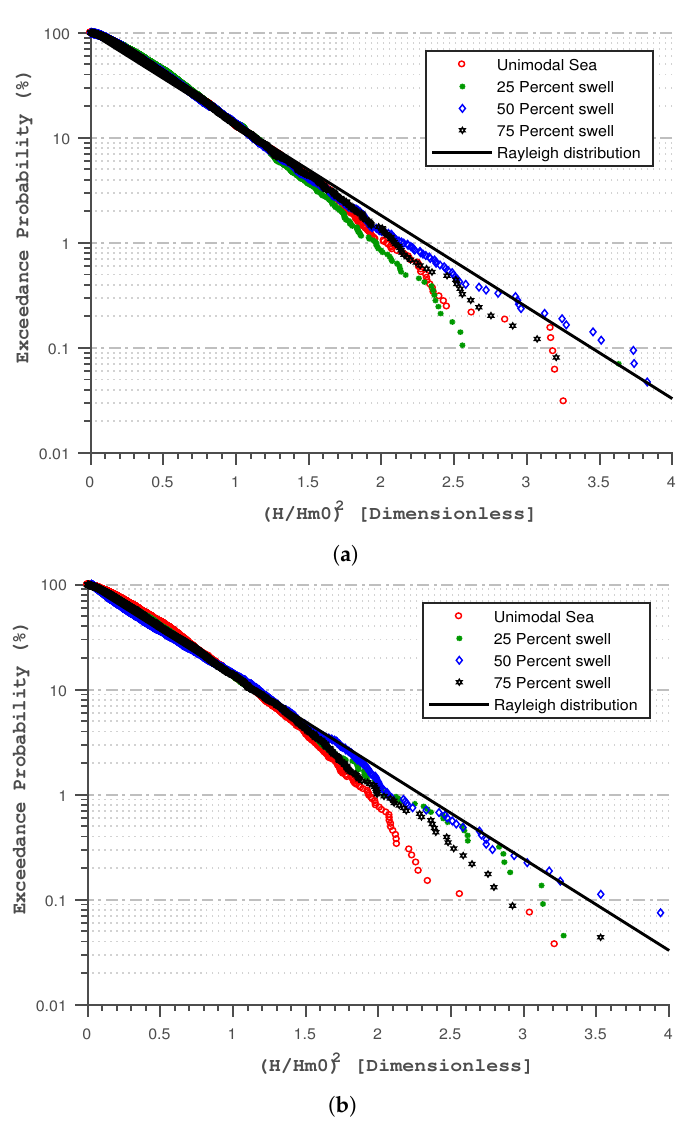
Figure 8. Effects of wave bi-modality caused by different swell percentages. ( a ) Wave height distribution for different swell percentages observed near the structure; ( b ) Distribution of wave heights for different swell percentages observed near the